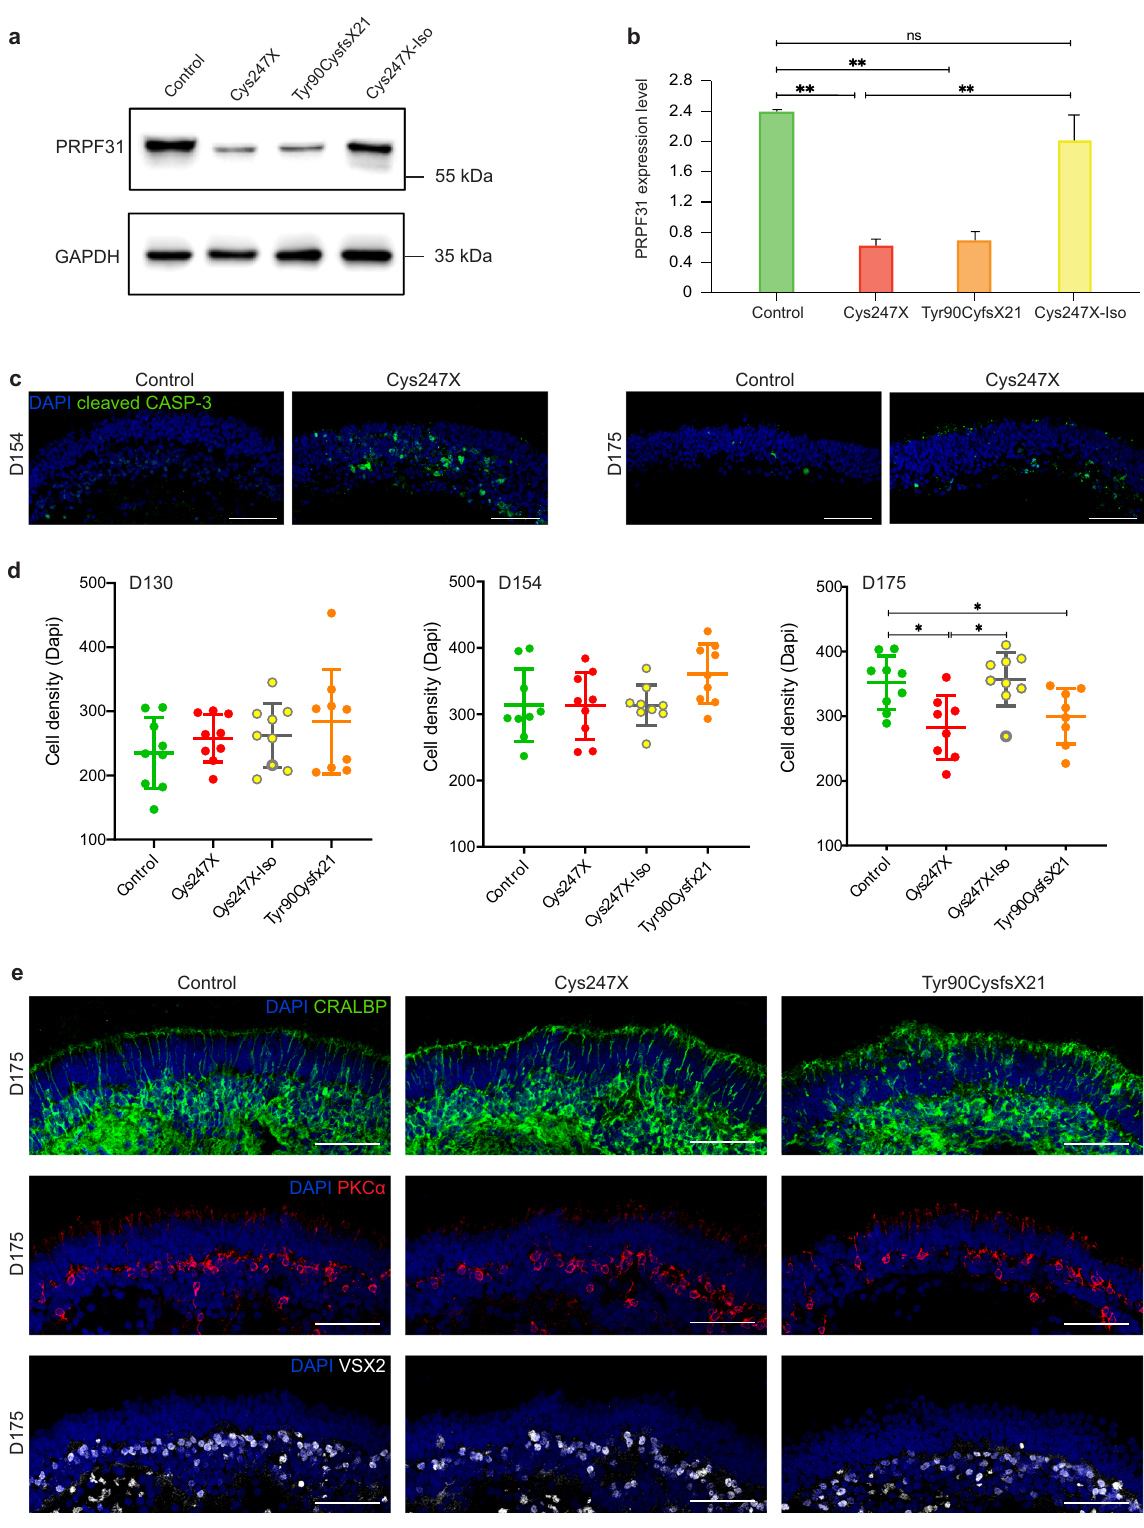
Cys247X vs Control and 545 DEGs for Cys247X vs Cys247X-As (Fig. 8a). Hierarchical clustering based on z score allowed the selection of 6 clusters where genes are differentially expressed between Cys247X and both Control and Cys247X-As RPE cells (Fig. 8b). These 6 clusters encompassed 337 DEGs including